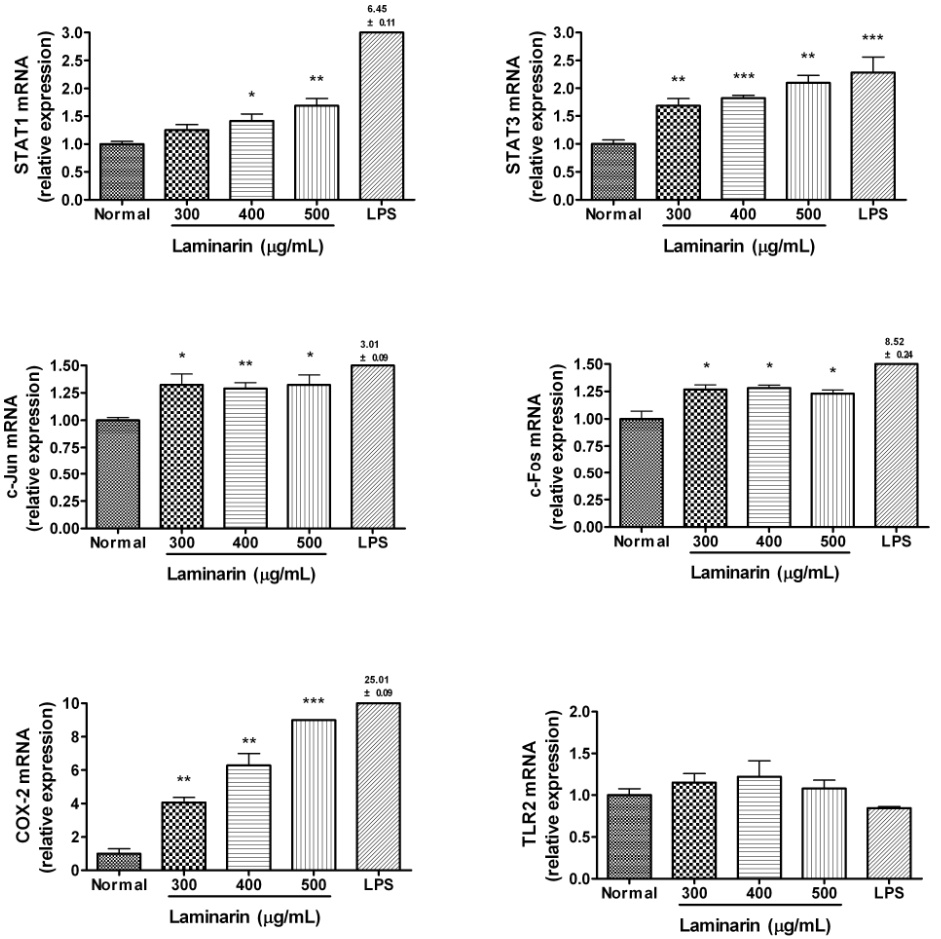
Figure 5. Effects of laminarin on mRNA expression of STAT1, STAT3, c-Jun, c-Fos, COX-2, and TLR2 in RAW 264.7 mouse macrophages. After 24 h incubation with laminarin, immune-related gene mRNA in cells was measured by a Quantitative bead-based multiplex gene assay. The normal group (Normal) was treated with medium only. Lipopolysaccharide (LPS; 1 µg/mL) was used as a positive control. Values are the mean + SEM of the three independent experiments. * p < 0.05 vs. Normal; ** p < 0.01; *** p <